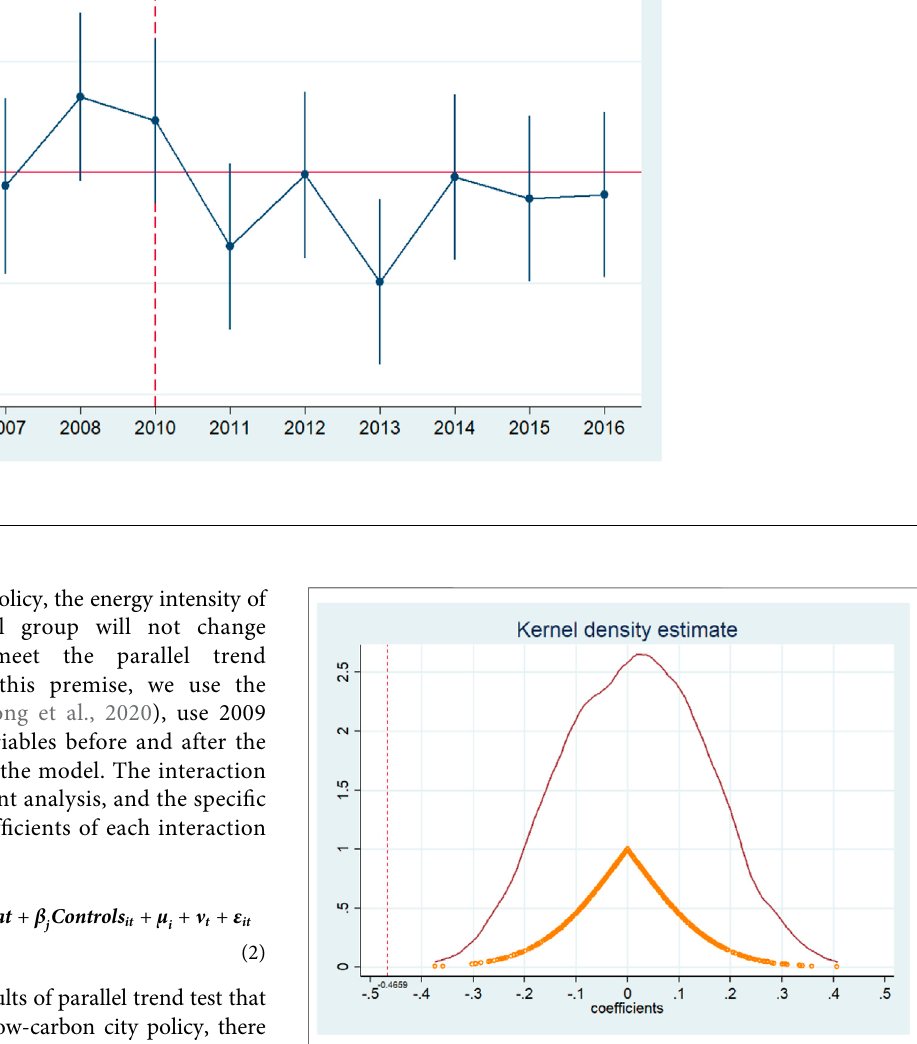
FIGURE 3 | Placebo test